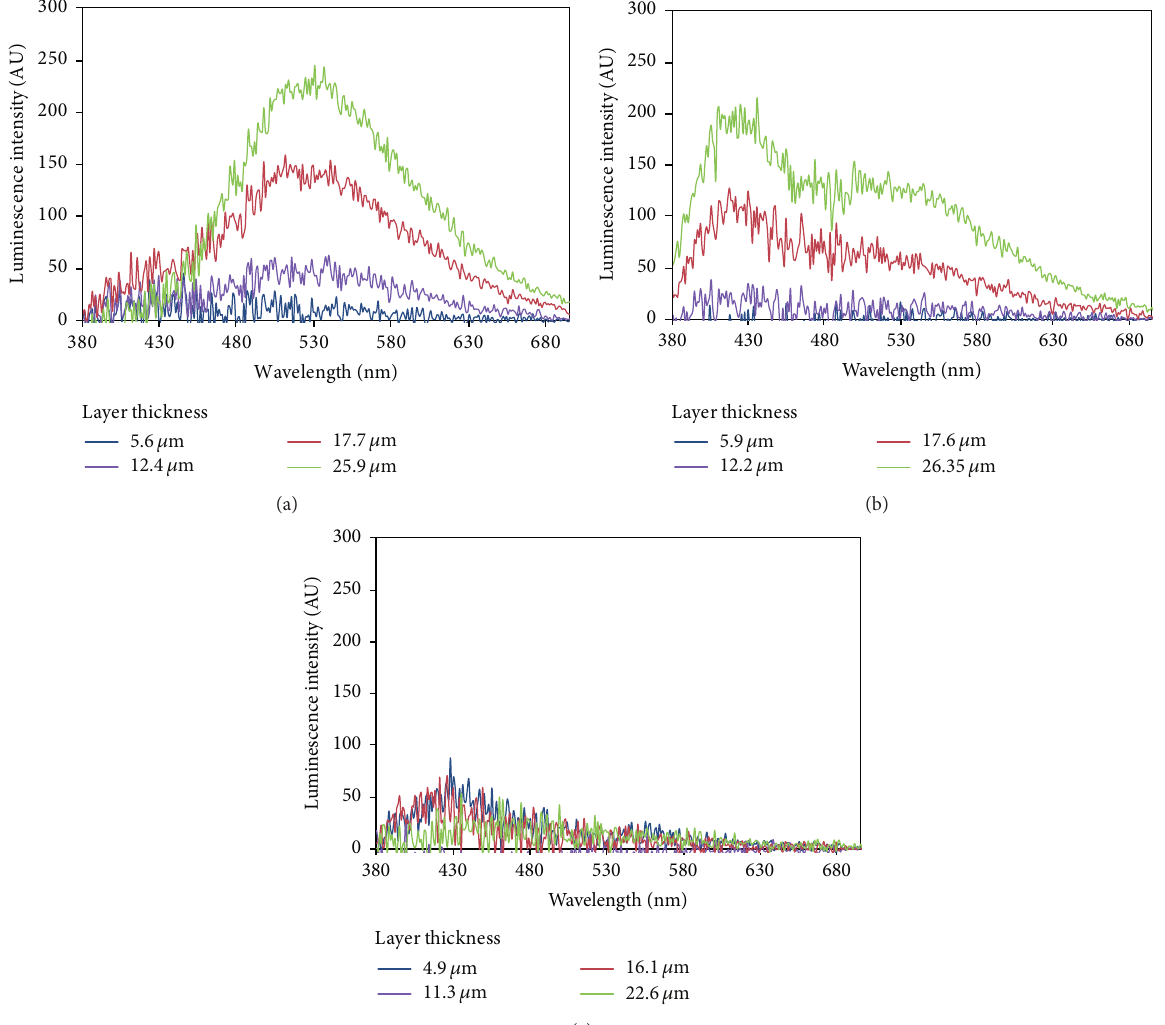
green-yellow luminescence colors can be obtained (with significant excess of luminescence peak in the medium wavelength area over the peak in short wavelength area of visible spectrum) and green, blue-green, and blue colors can be obtained (with significant excess luminescence peak in the short wavelength area over the peak in medium wavelength area of visible spectrum). At medium and low concentrations of the fluorescent component in the ink composition, only blue-green and blue colors can be on a printed image. peaks at 𝜆 = 520 nm on ink layer thickness of printed